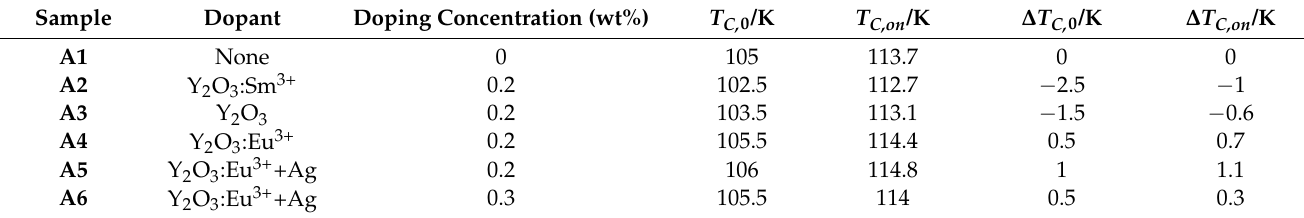
Table 1. Dopant, doping concentration, T C, 0 , and T C,on of A series samples prepared from raw material S1 (30 µ m). Sample